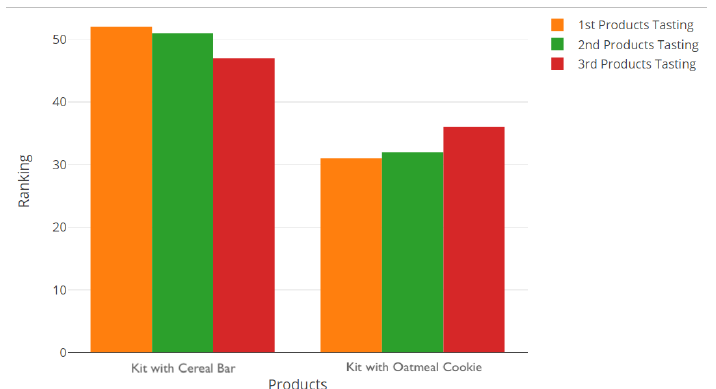
Figure 6. Results of the preference test between a breakfast kit with a cereal bar ( left ) and an oatmeal cookie ( right ) throughout the three